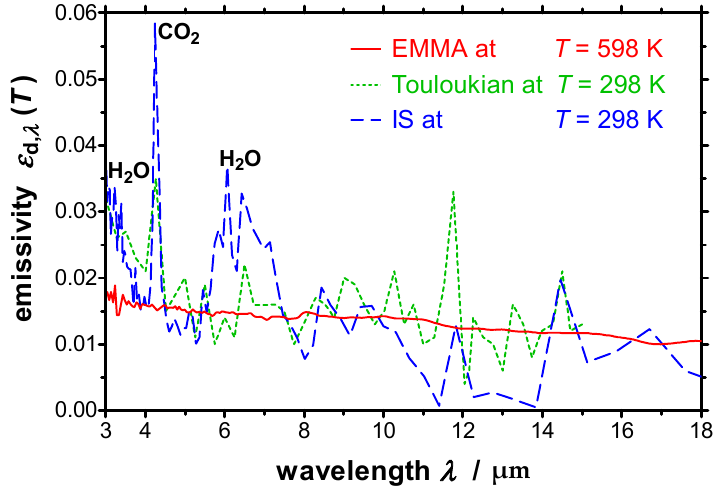
Figure 14. Spectral directional emissivity of polished copper near-normal to the surface measured with the EMMA together with the emissivity measured by an integrating sphere (IS). Additionally, values taken from Ref. [36] are given in the graph for comparison.